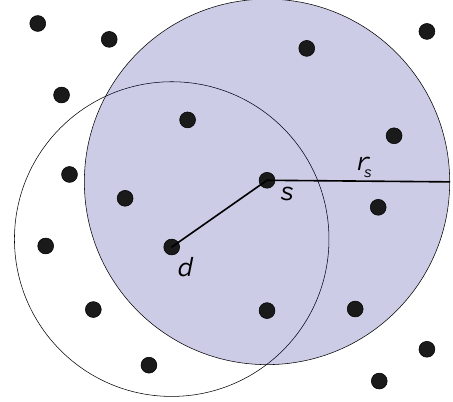
Figure 8. The network model of PTC algorithm.